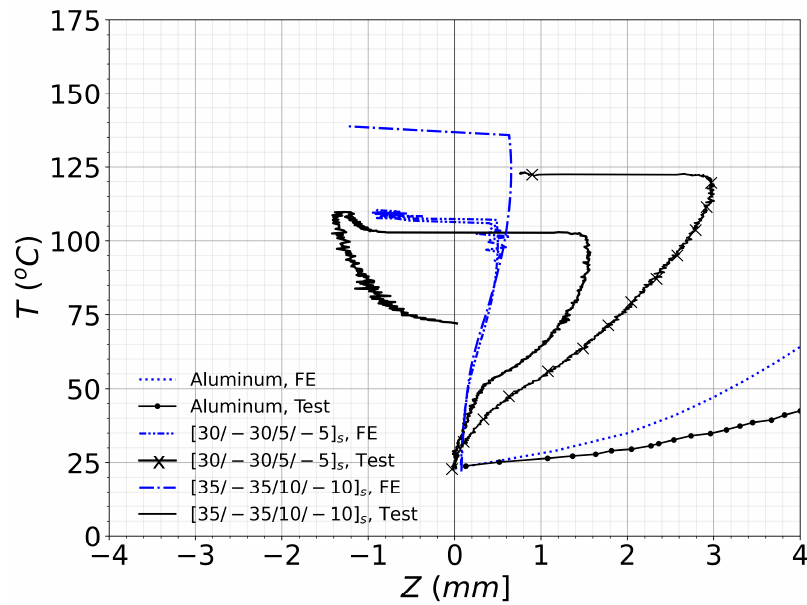
Figure 13. Temperature vs. out-of-plane deformation for the three plates.